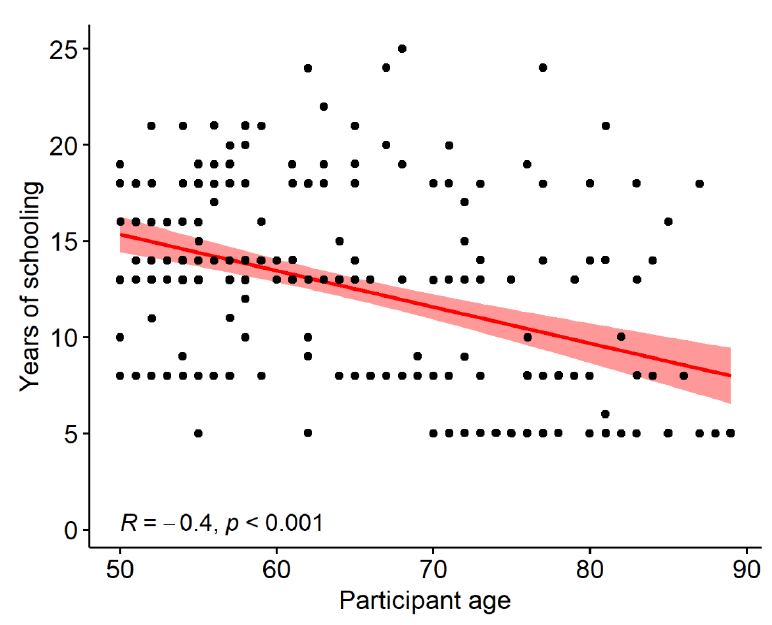
Figure A2. Years of schooling as a function of age.